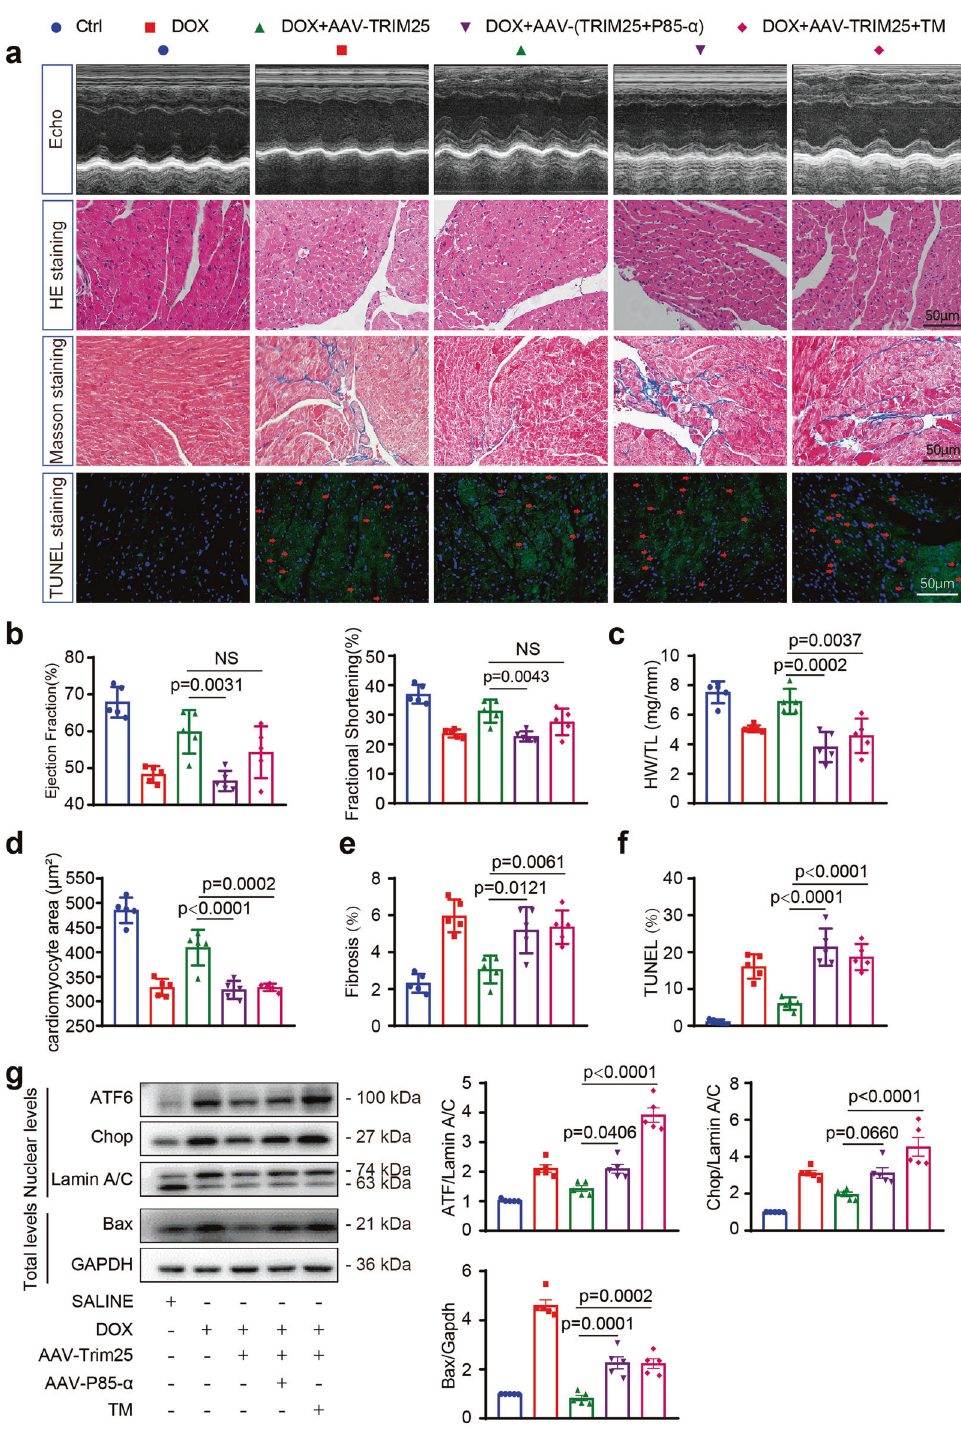
Fig. 7 Pharmacological augmentation of endoplasmic reticulum stress or p85 α overexpression abolishes cardioprotection in TRIM25 OE mice. TRIM25 or p85 α overpression (OE) mice were injected by adeno-associated virus 9 via the tail vein, and after 4 weeks, they were treated with a cumulative dose of 20 mg/kg DOX by 4 weekly injections (5 mg/kg on days 0, 7, 14, and 21) and TM (tunicamycin) (2 mg/kg on days 0, 7, 14, and 21). a Representative M-mode echocardiographic images as well as H&E, Masson, and TUNEL staining in heart sections from CON, DOX, AAV-TRIM25, AAV-p85 α , and TM-administered mice. b M-mode images from three cardiac cycles for each animal were used to calculate ventricular measurements: ejection fraction, fractional shortening. c The HW/TL (heart weight/tibia length) ratio as a cardiac atrophy index of mice. ( d , e , f ) Relative quanti fi cation of cardiomyocyte area, fi brosis, and TUNEL-positive nuclei per fi eld in heart sections from CON, DOX, AAV- TRIM25, AAV-p85 α , and TM-administered mice. g Nuclear protein amounts of ATF6, CHOP, and Lamin A/C in mice hearts treated with DOX, AAV-TRIM25, AAV-p85 α , and TM. Western blot and relative quanti fi cation for Bax in heart tissue from mice infected with DOX, AAV-TRIM25, AAV-p85 α , and TM. N = 5 animals/group; Values represent mean ± SEM. Scale bar, 50 μ m in a. TM tunicamycin.